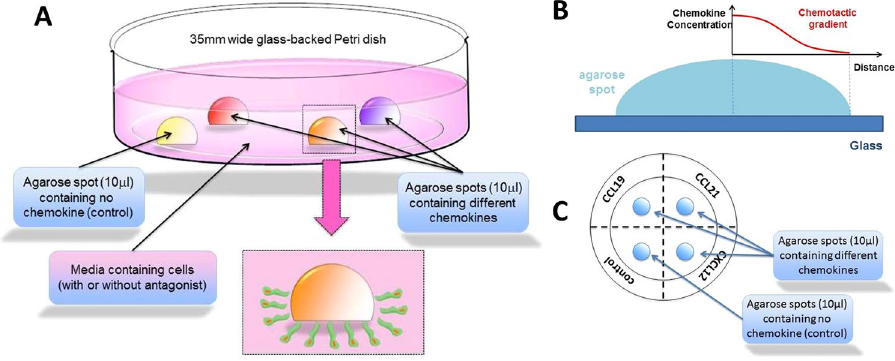
Figure 1. ( A ) A schematic representation of a glass backed 35 mm petri dish with three agarose drops containing chemokines, and one agarose drop containing PBS as control. Cells migrate under the agarose spot in response to the chemokines. ( B ) A schematic representation of chemotactic gradient established within the agarose spot ( C ) A schematic representation of glass back Petri dish with agarose drops from the top, dotted line and writing on the bottom of the Petri dish are also